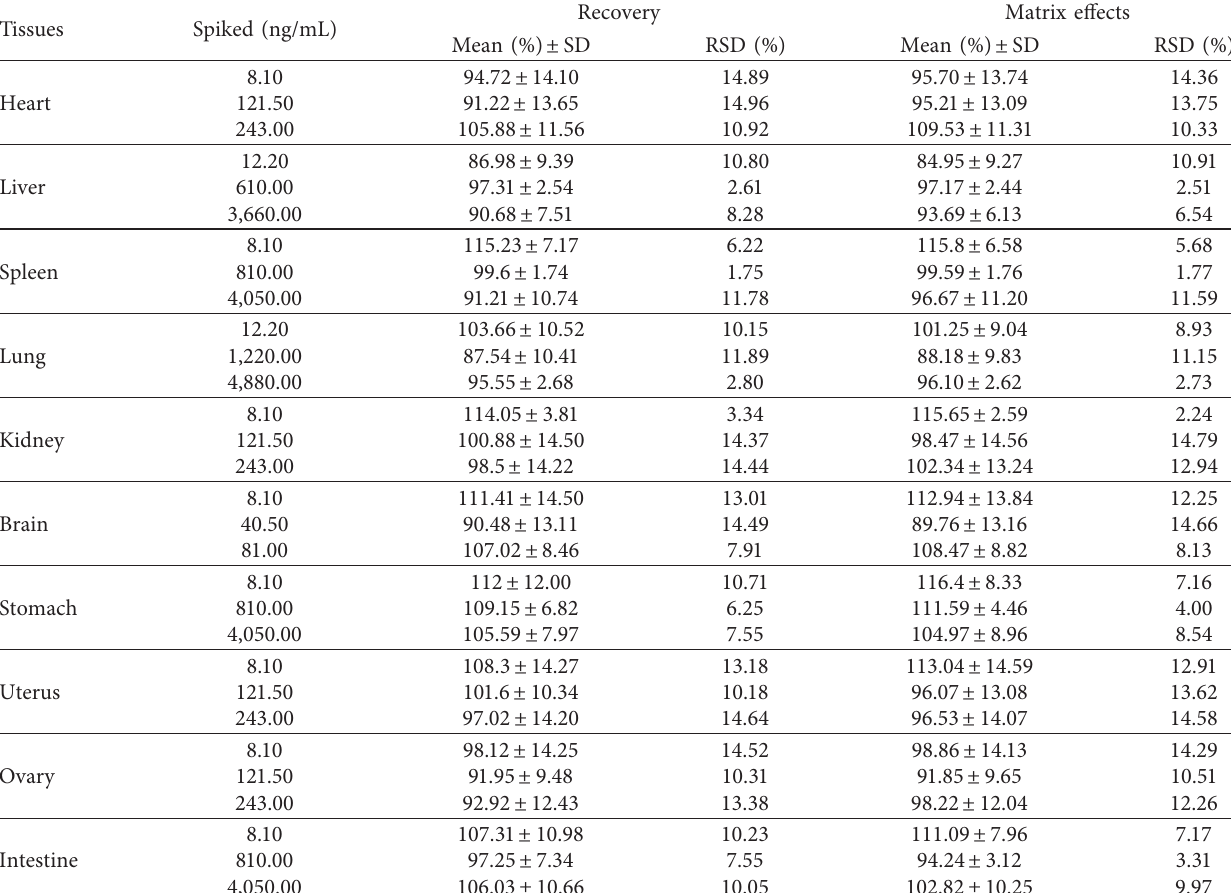
Table 10: Recovery and matrix effect study of neoeriocitrin in rat tissues ( n � 6).